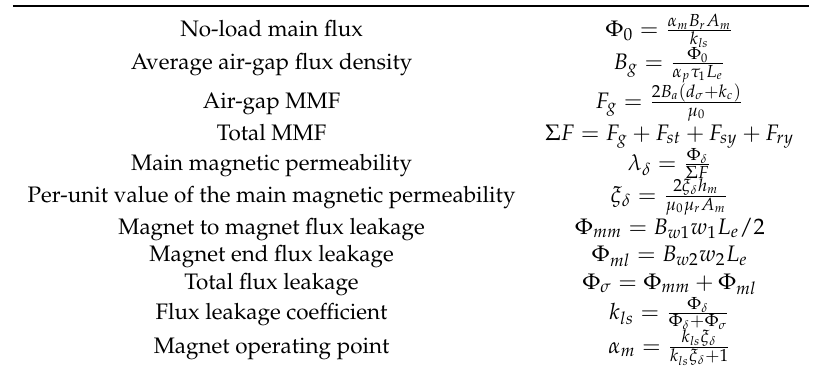
Figure 11. Flow chart of the procedure of the calculation. Table 1. Magnetic circuit